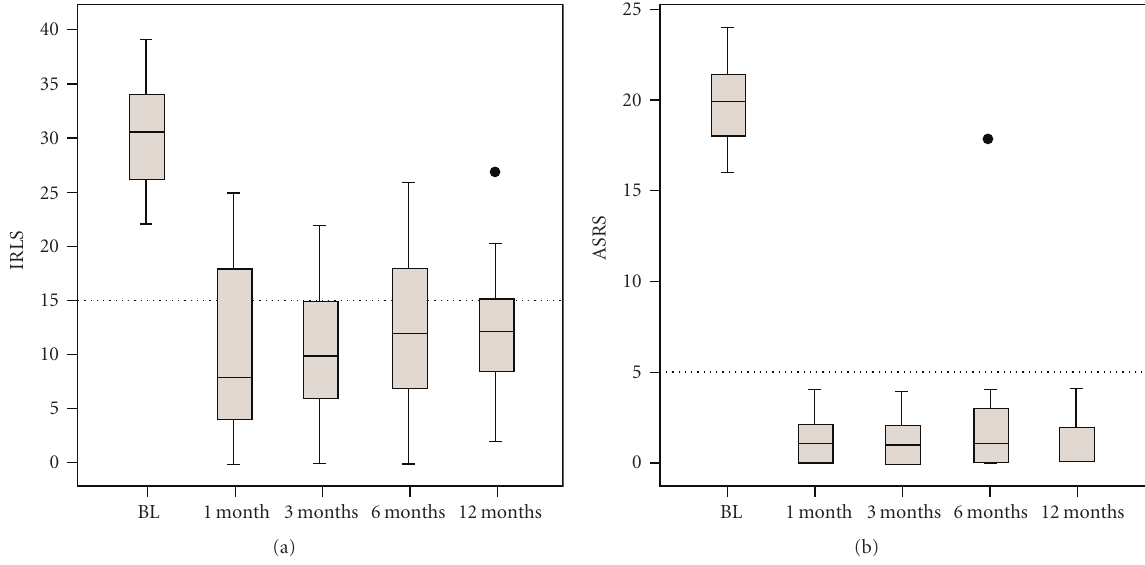
Figure 1: Serverity of RLS symptoms and augmentation. BL: baseline, IRLS: International RLS Study group rating scale, mo: months. (a) International RLS Severity rating scale IRLS. Values below the horizontal spaced line indicate fully e ff ective treatment (IRLS < 16 points). (b) Augmentation severity rating scale